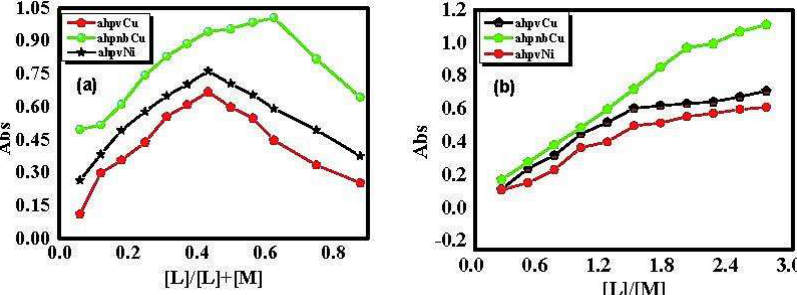
Figure 1. ( a ) Continuous variation, and ( b ) molar ratio plots for the prepared complexes in aqueous ethanolic solution at [M] = [L] = 1 × 10 −3 M and 298 K.